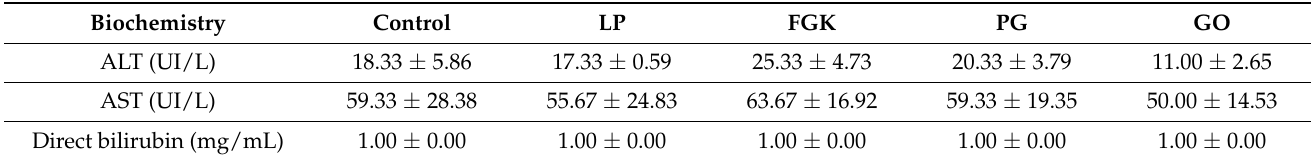
Table 3. Analysis of the biochemical parameters of the rat’s blood.